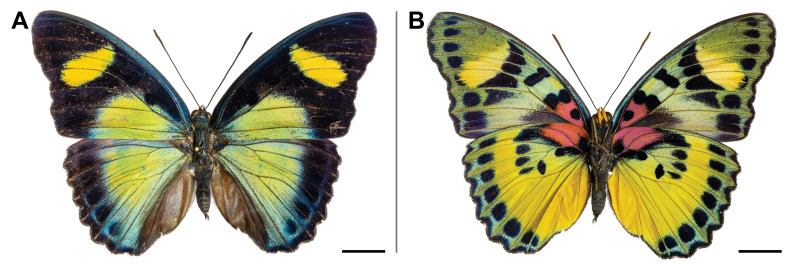
Euphaedra
temeraria Hecq, 2007. A. dorsal view; B. ventral view. The scale bar represents 1 cm.